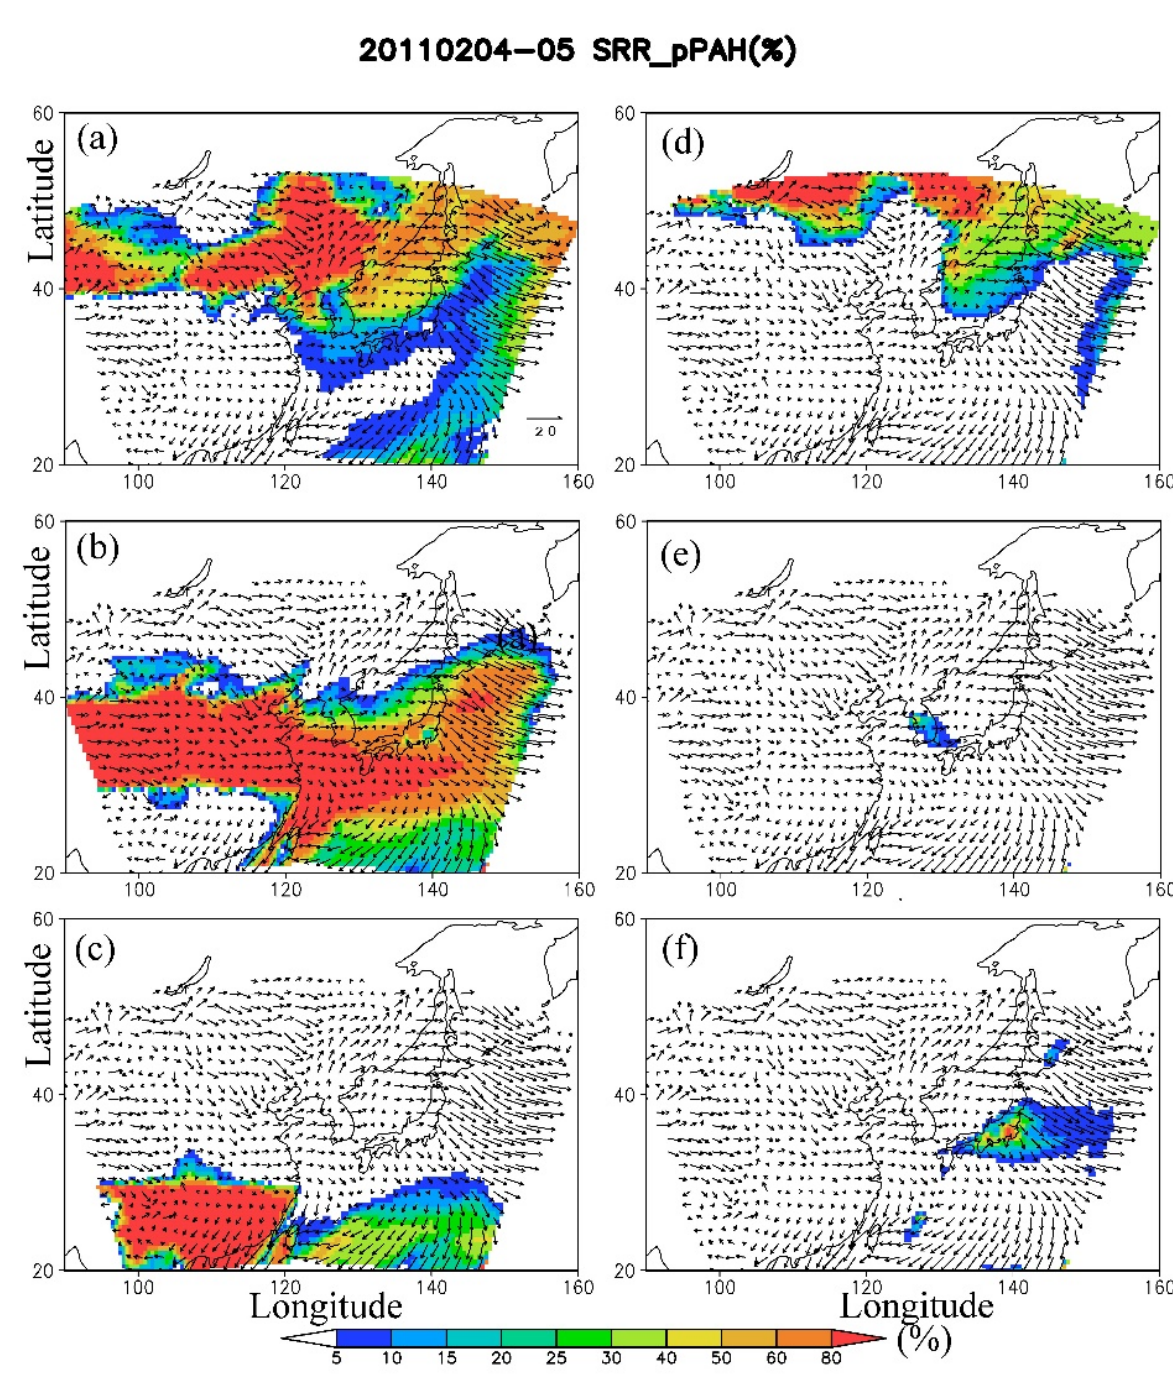
Figure 5. Spatial distributions of the relative contributions (%) to the p-PAH concentration of the six source domains from 4–5 February 2011. ( a ) NCHN, ( b ) CCHN, ( c ) SCHN, ( d ) ERUS, ( e ) SKOR, and ( f ) JPN. After spring, the p-PAH concentration gradually decreased. The p-PAH concentration during the spring/summer season (May–June) ranged from 65 to 1507 ng m − 3 , with an average value of 467 ± 268 ng m − 3 . With decreasing p-PAH concentrations the relative con- tributions from CCHN and NCHN gradually decreased, whereas the relative contributions from JPN, the self-domain, increased (88–100%) in